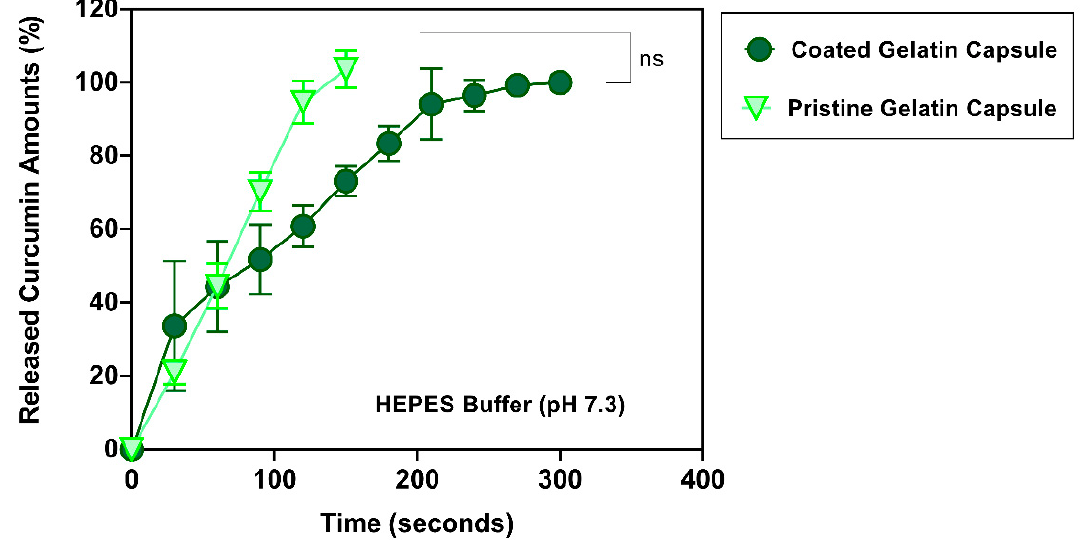
Figure 8. Accumulated curcumin release profiles from different gelatin capsules over time at pH 7.3. (n = 3 in each condition). ns: no statistical difference.